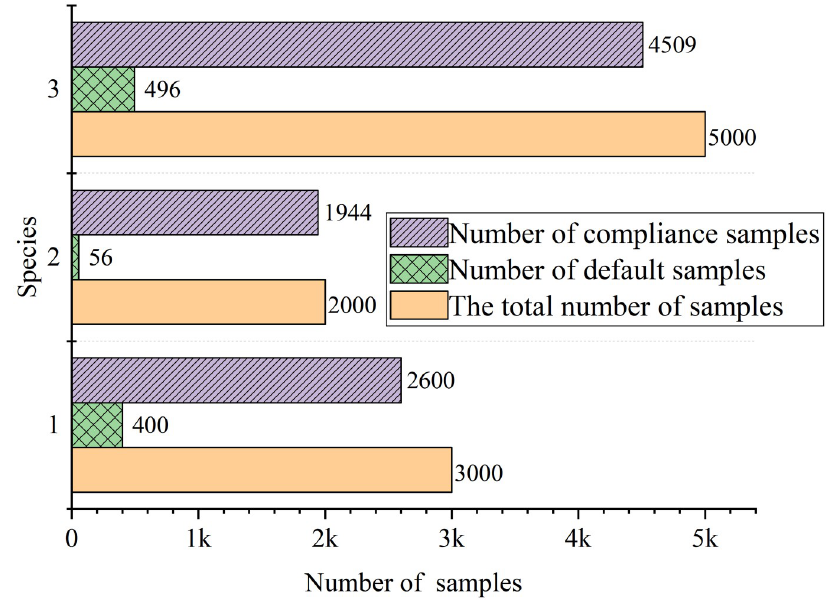
Fig 5. Sample set distribution.